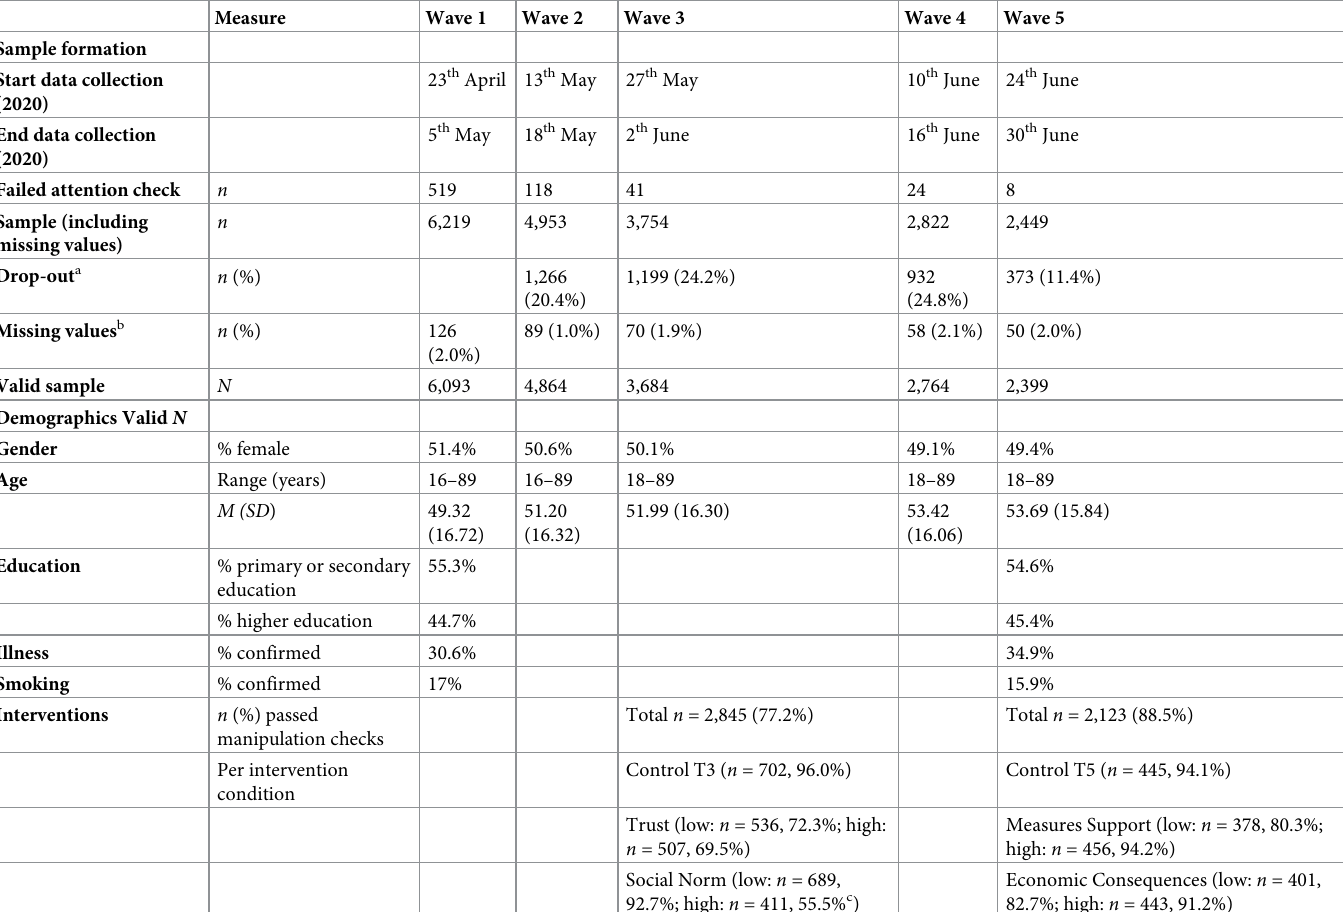
Table 1. Demographic and intervention